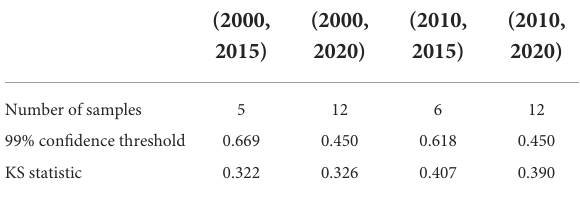
TABLE 3 KS test of Transient type: the critical value of the KS statistic at 99 % confidence and the KS statistic for each fixed time horizon.